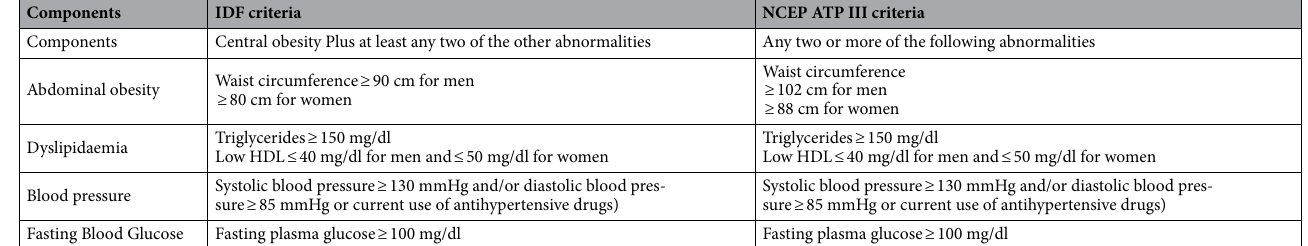
Table 1. Classification criteria for metabolic syndrome based on IDF and NCEP ATP III.